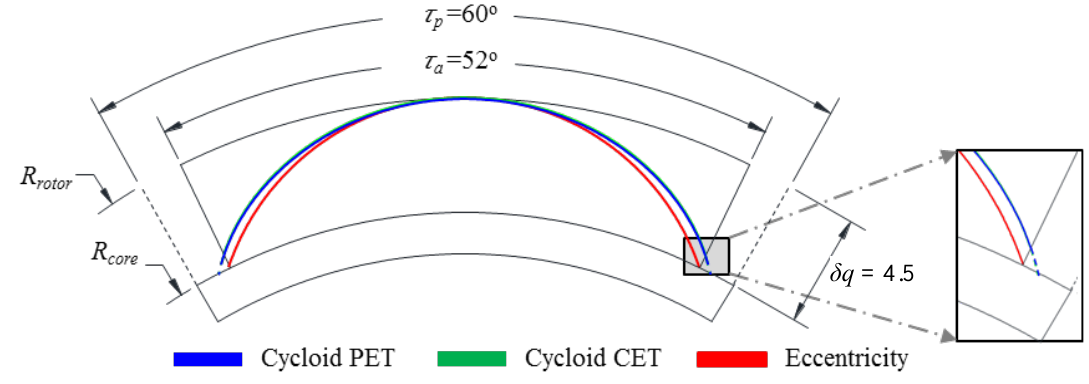
Figure 7. Magnet shape at δq = 4.5: CET, PET, and eccentricity.